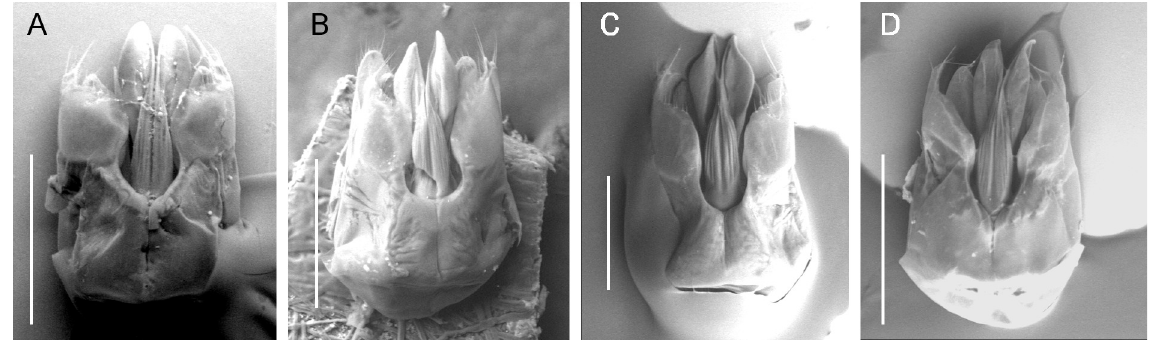
Fig. 9. Male genitalia of Chrysidea spp. A . C. pumiloides Zimmermann, 1956. B . C. vazimba sp. nov. C . C. phoebe Zimmermann, 1956. D . C. rioae sp. nov. Scale bars = 0.25